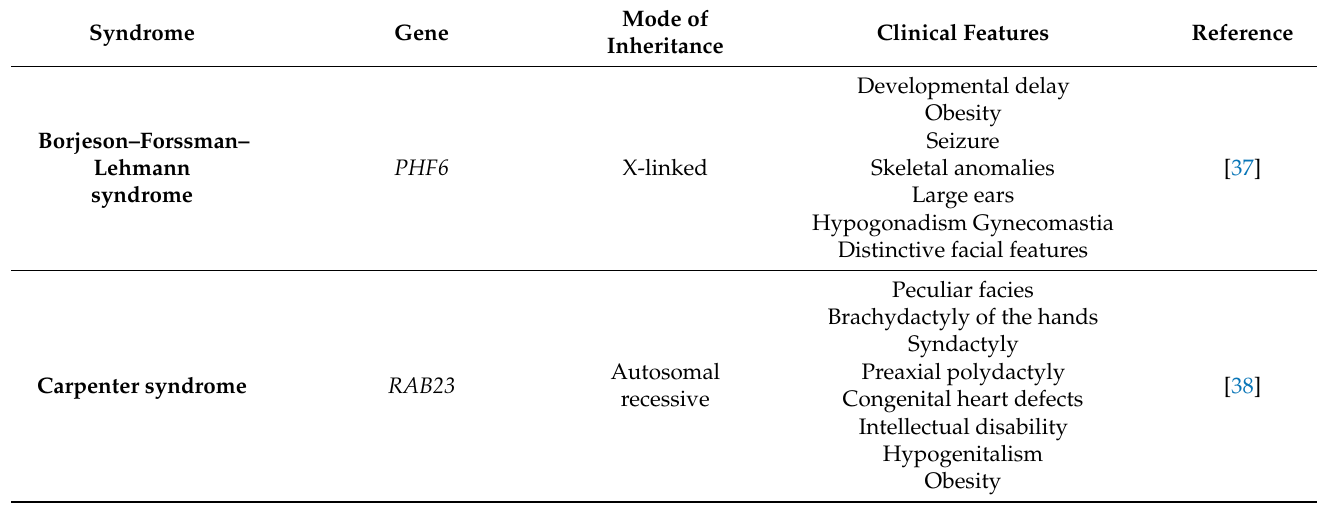
Table 1. Other obesity-related disorders with reported clinical and genetic